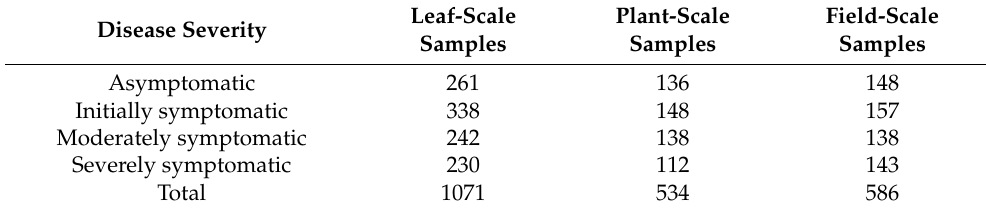
Table 2. Number of samples at different